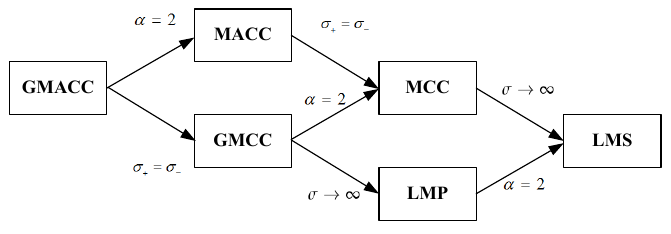
Figure 1. Relationship between the GMACC and other